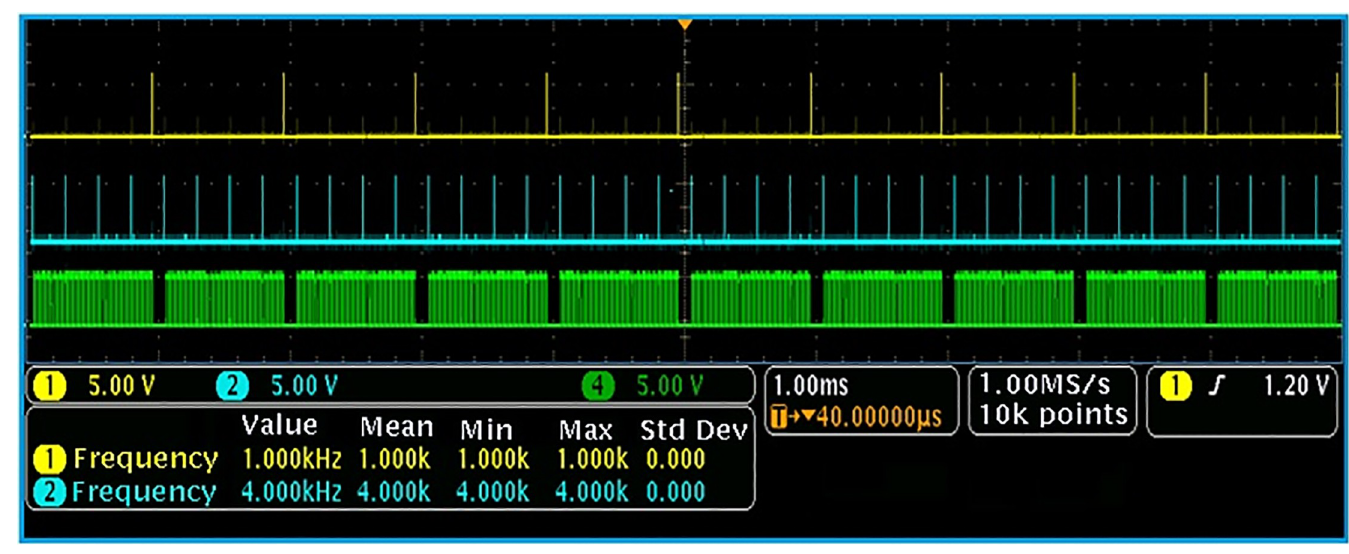
Fig 7. Group quantization test results.